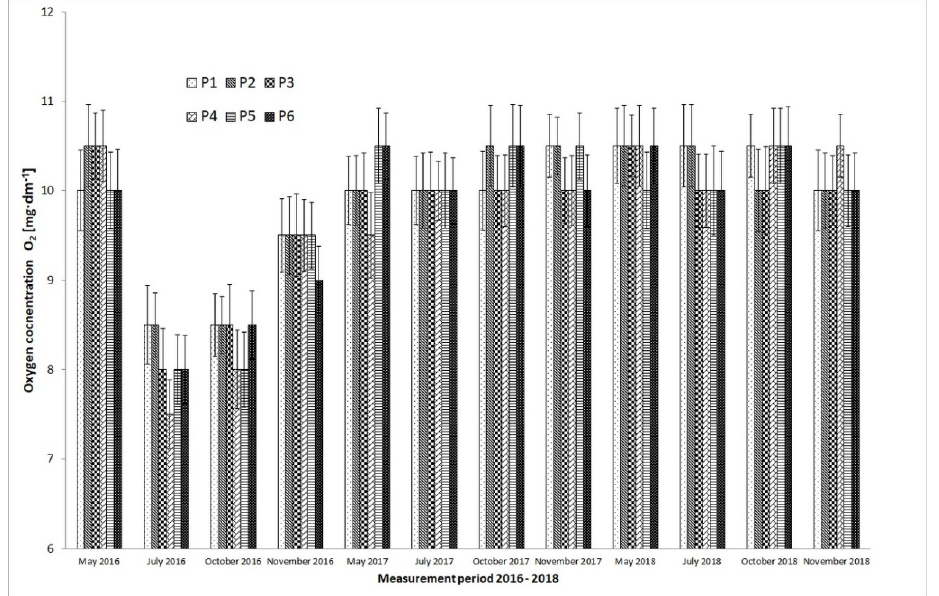
Figure 5. Changes in water transparency in the years 2016–2018, measured with a Secchi disk.